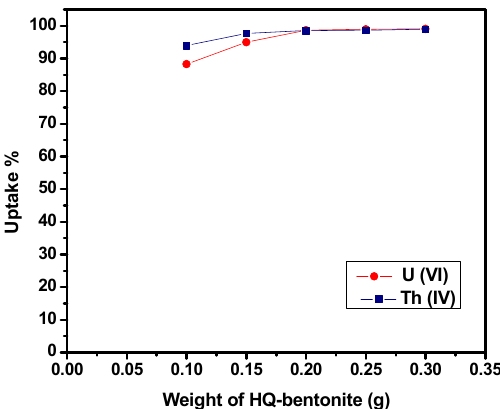
Figure 9. Effect of adsorbent mass on U(VI) and Th(IV) ions sorption onto HQ-bentonite. Conditions: 100 mg/L metal ion; 50 mL solution; U(VI) (pH 4), Th(IV) (pH 3); shaking time U(VI) (15 min.), Th(IV) (8 min.); temperature = 303 K.